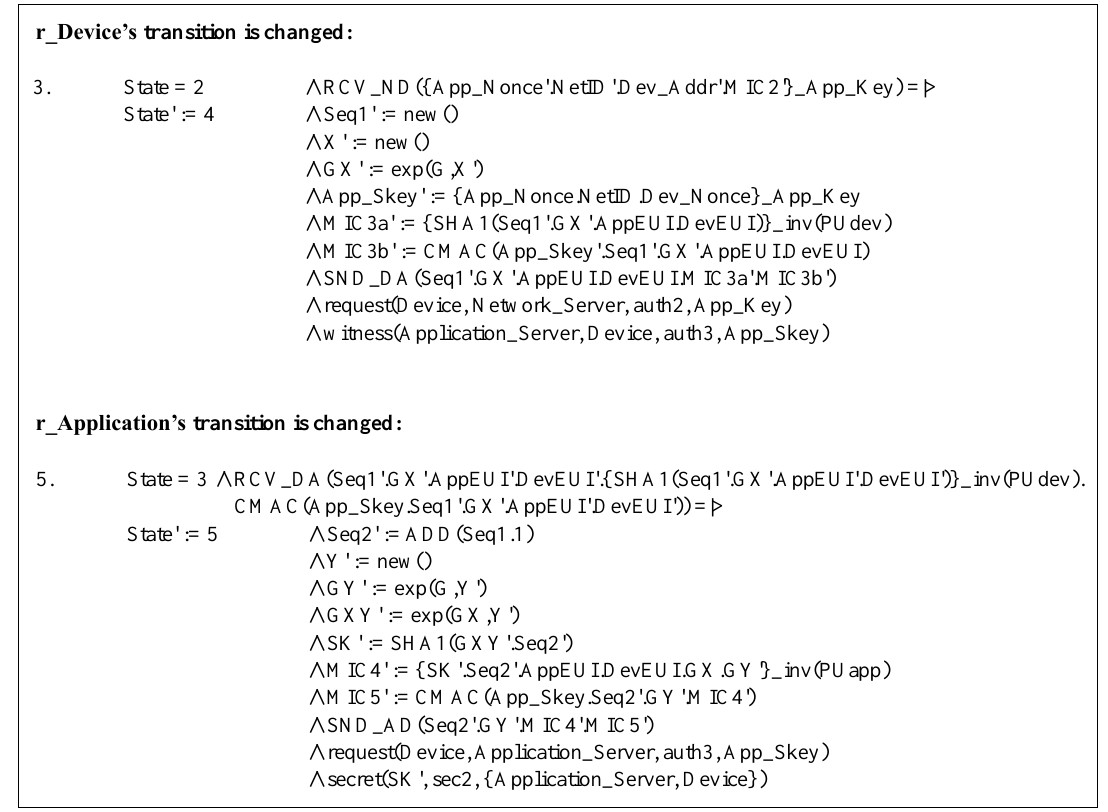
Figure 12. Major changes in the Security-Enhanced Option (SEO).